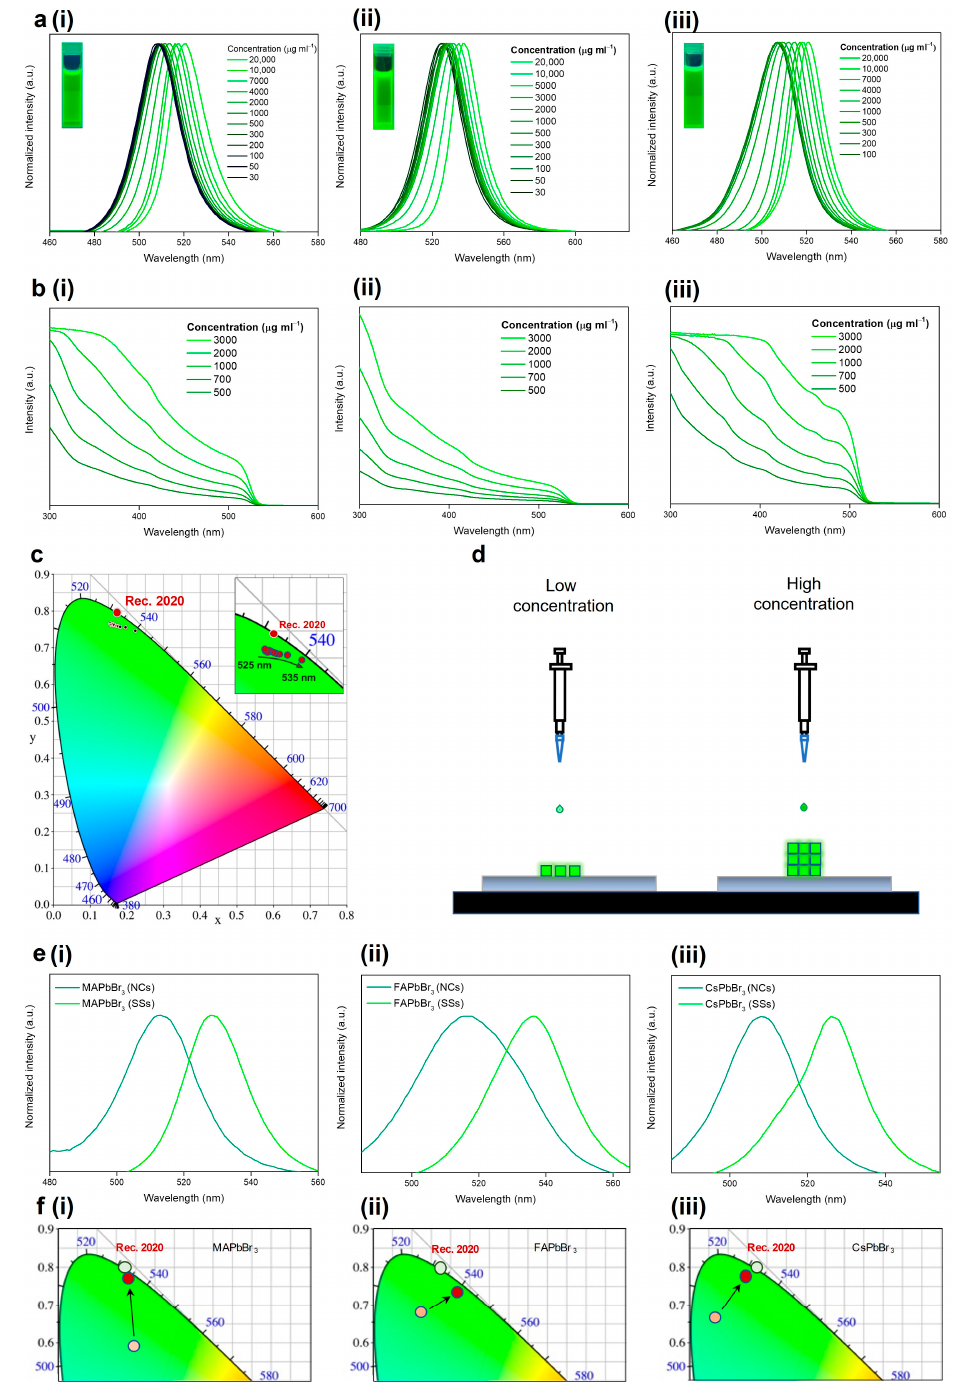
Figure 3. ( a ) PL spectra of the colloidal ( i ) MAPbBr 3 , ( ii ) FAPbBr 3 , and ( iii ) CsPbBr 3 under 365 nm excitation. ( b ) Absorption spectra of ( i ) MAPbBr 3 , ( ii ) FAPbBr 3 , and ( iii ) CsPbBr 3 . All colloidal samples were dispersed in hexane. ( c ) Color gamut in the CIE chromaticity diagram of colloidal MAPbBr 3 at different concentrations. ( d ) Schematic illustration of sample preparation on ITO film. ( e ) PL spectra and ( f ) CIE chromaticity diagrams of ( e,f ( i )) MAPbBr 3 , ( e,f ( ii )) FAPbBr 3 , and ( e,f ( iii )) CsPbBr 3 thin-film NCs (light red) and SSs (dark red) emissions under 365 nm excitation. While the emission peaks change with concentration, the absorption band edges of the samples are constant and do not change with concentration, which is also consistent with previous works (Figure 3b) [9,10]. Notably, the Rec. 2020 standard requires a